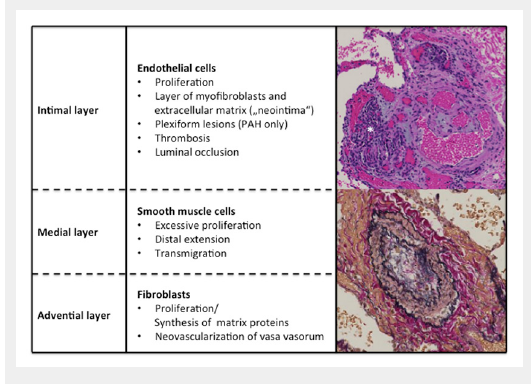
Features of pulmonary artery vascular remodelling in different cell types. All vascular cell types (endothelial cells, smooth muscle cells and adventitial fibroblasts) are involved in pulmonary artery remodelling and are characterised by excessive proliferation. The accumulation of myofibroblasts and extracellular matrix proteins within the endothelial layer is termed “neointima”. Plexiform lesions (shown by white star) are a system of thin-walled, dilated vessels as consequence of endothelial proliferation. These lesions are found exclusively in pulmonary arterial hypertension (PAH). The most prominent changes are observed within the vessel’s medial layer and mediated by a imbalance between proproliferative and apoptotic activity of smooth muscle cells and transmigration of these cells and myofibroblasts in the endothelial layer. Within the adventitial layer, neovascularisation of vasa vasorum and increased production of matrix proteins is observed (shown by Elastin-Van Gieson (EVG) staining). These alterations result in excessive hyperplasia, increased vessel thickness and luminal occlusion (reviewed in [70]).